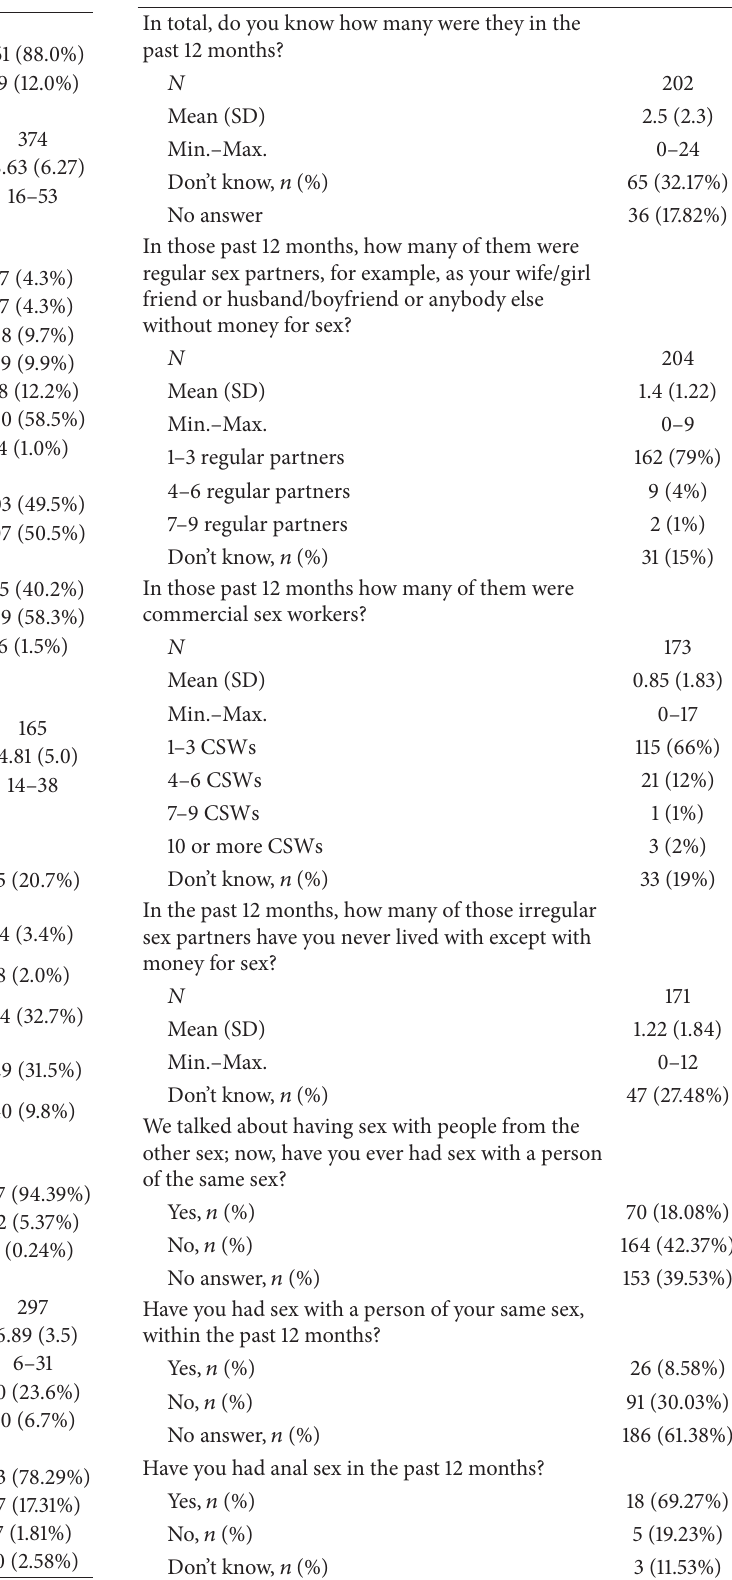
Table 1: Sample characteristics and sexual